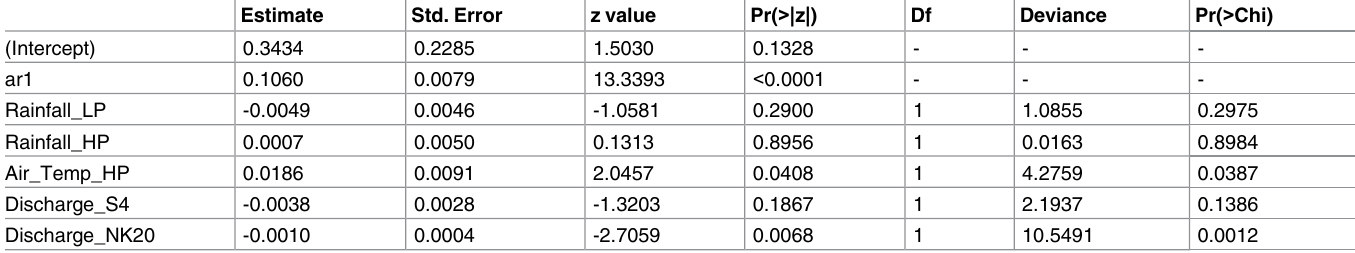
Table 3. Effect of environmental variables on total incidence from 1 January 2010 to 31 December2012. The last three columns present the results of the LRT and show the significances of each variable,correcting for the potentialconfounding effects of the other variables. ar1 is the 1-step laggedincidence